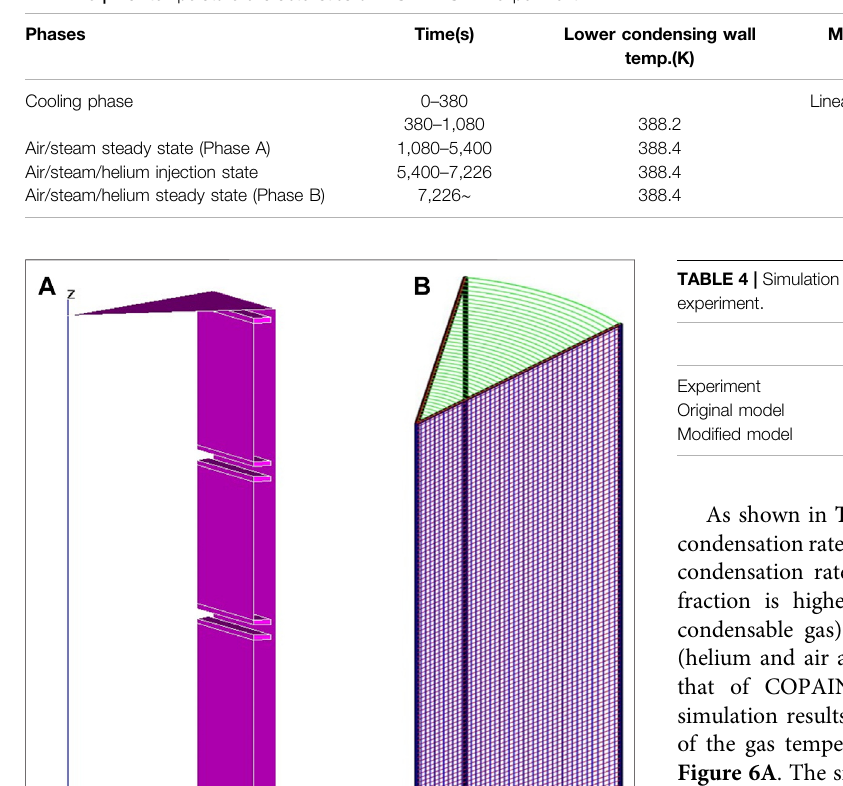
TABLE 3 | Wall temperature characteristics of MISTRA ISP47 experiment.